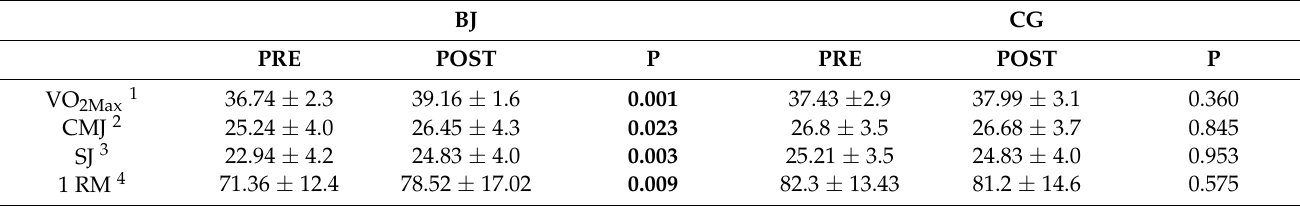
Table 3. Pre- and post-test results of variables related to physical fitness.